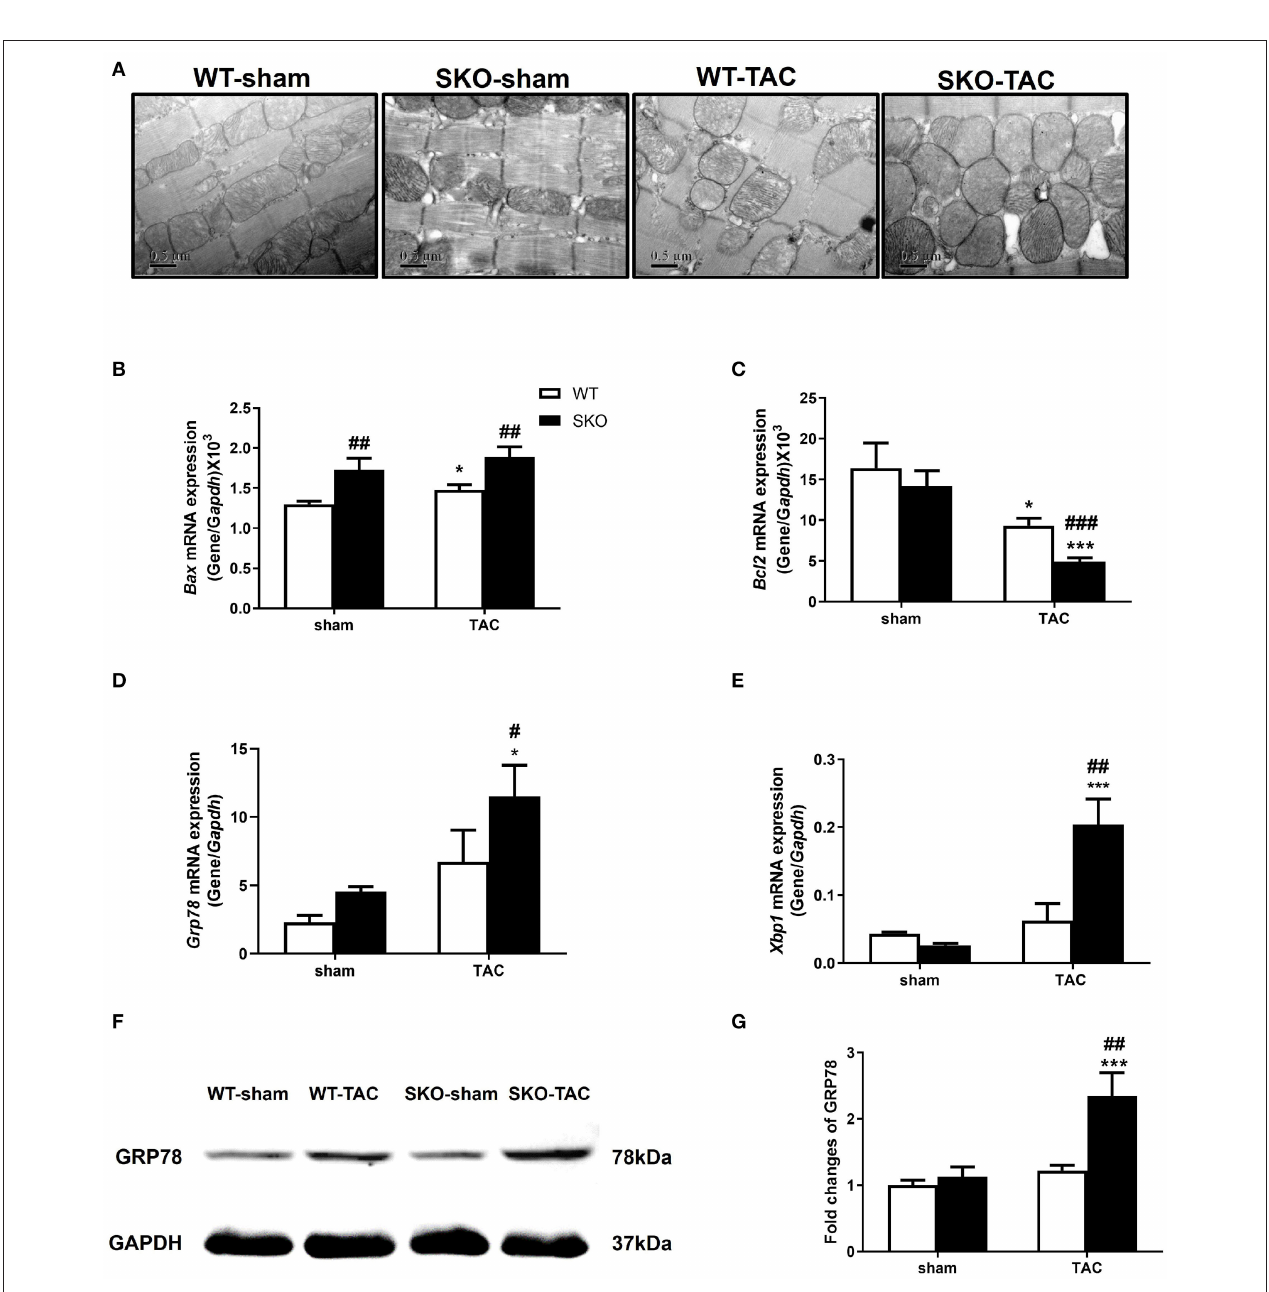
FIGURE 4 | Seipin deficiency aggravated myocardial ultrastructure changes and increased endoplasmic reticulum stress and apoptosis after TAC. (A) Representative cardiac electron microscopy images (original magnification, 40,000 × ); (B–E) mRNA expression levels of Bax, Bcl2, Grp78, and Xbp1, in the heart; (F,G) Western blot analysis of GRP78 and densitometric quantitation. The results are represented by the ratio of the values of the experimental groups to those of the WT control group. * P < 0.05, *** P < 0.001, effect of TAC; # P < 0.05, ## P < 0.01, ### P < 0.001, effect of genotype. WT, Wild-type; SKO, Seipin knockout; TAC, transverse aortic